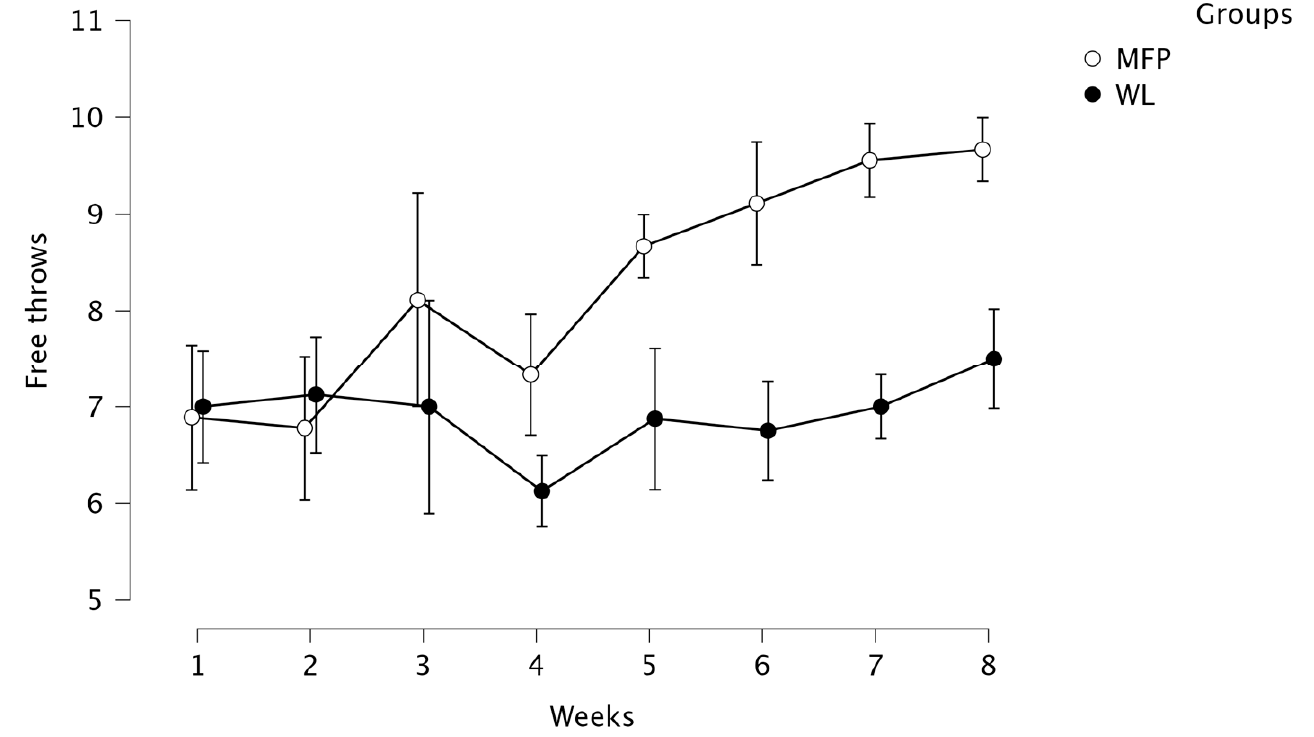
Figure 1. Average of successful free throws during training sessions per week. Note: week 1 = before the intervention, week 1 to 7 = intervention, week 8 = one week after intervention.